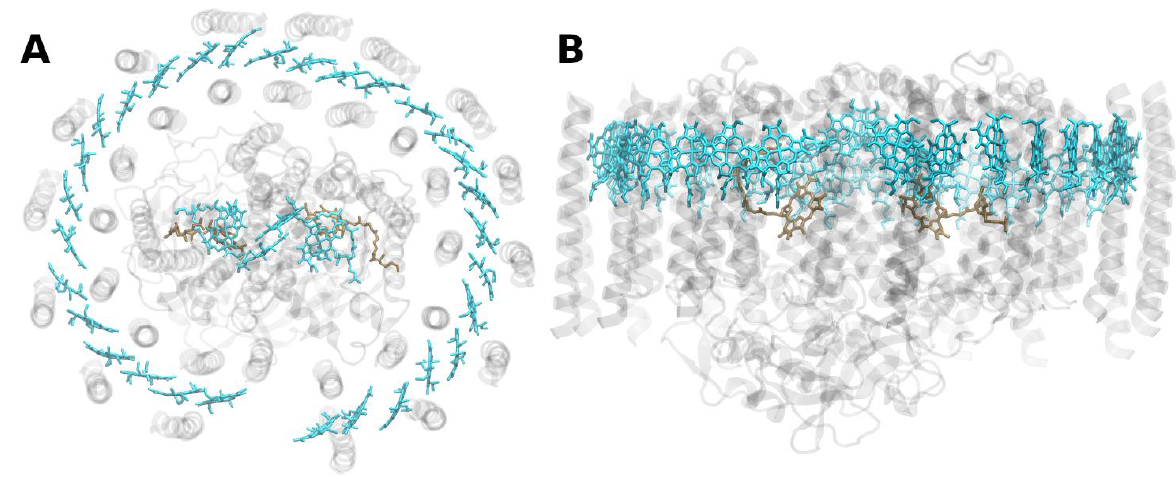
Figure 7. Structure of the purple-bacterial core-antenna reaction center complex (LH1-RC) from Rhodopseudomonas palustris at 4.8 Å resolution, PDB entry 1PYH [86]. ( A ) Top view with regard to the bacterial membrane plane, seen from the cytoplasm. ( B ) Side view with regard to the bacterial membrane plane. The protein backbone is shown in grey. Bacteriochlorophyll a is shown in light cyan, bacteriopheophytin a in brown.